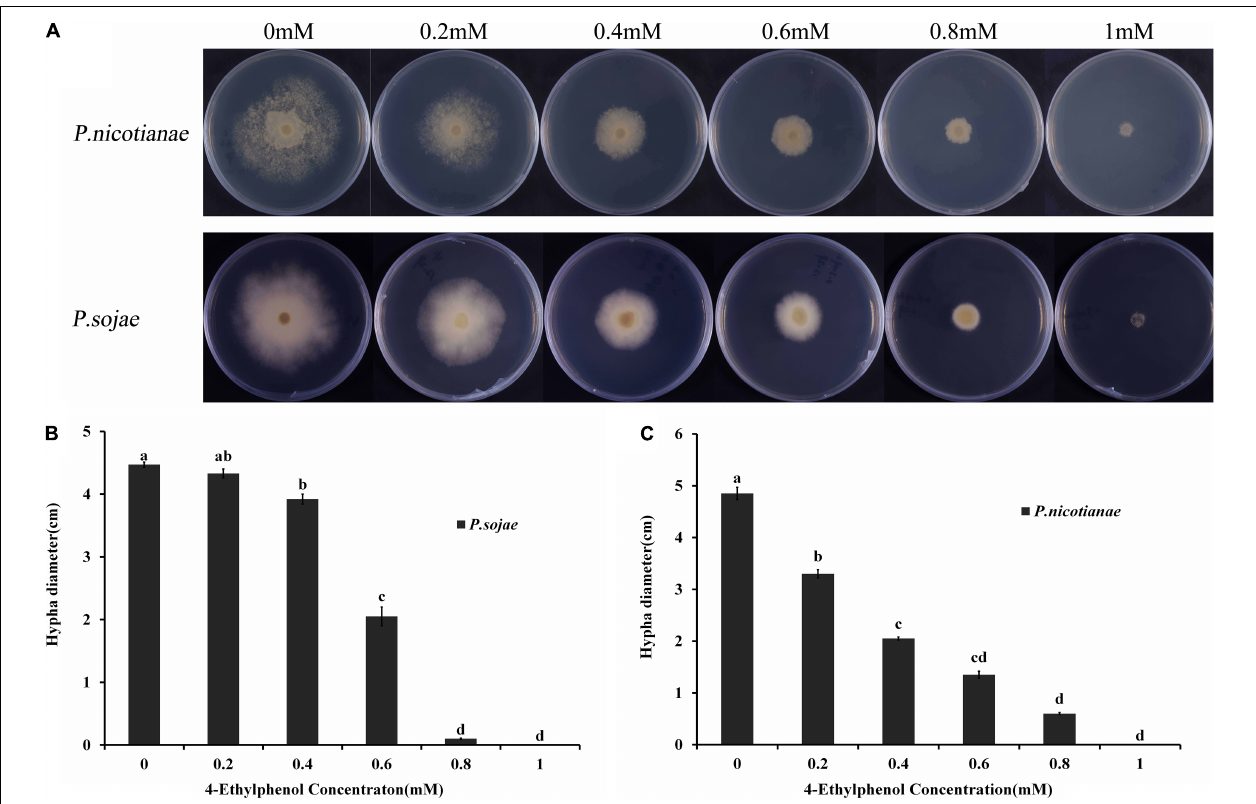
FIGURE 1 | Antifungal activity of 4-Ethylphenol against Phytophthora spp. (A) P. sojae and P. nicotianae were cultured on V8 medium with different concentrations of 4-Ethylphenol. (B) Colony diameters of P. sojae were measured after 5 days. (C) Colony diameters of P. nicotianae were measured after 5 days. The experiment was repeated three times with similar